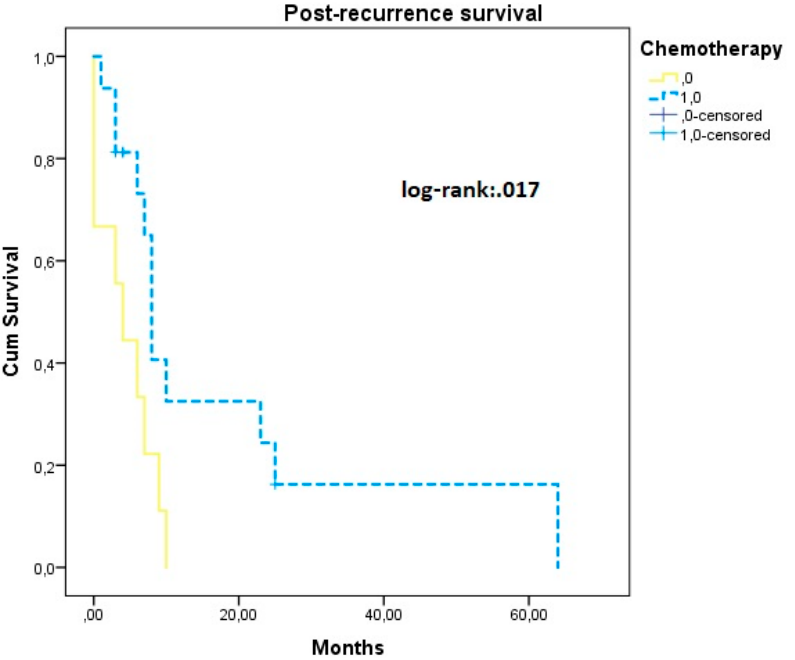
Figure 3. Post-recurrence survival according to the use of chemotherapy. Yellow dotted line: declined chemotherapy; blue continuous line: received chemotherapy.